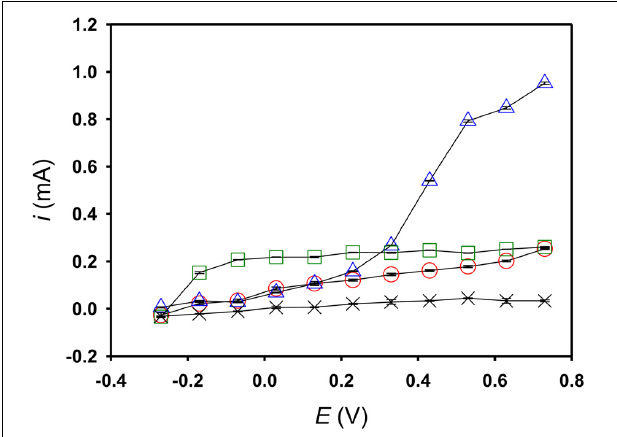
FIGURE 4 | The steady-state catalytic currents of the acetate degradation recorded at different applied potentials. Open circle, S. decoloration NTOU1 digesting acetate without any mediator addition; open square, with 10 µ M riboflavin addition; open triangle, with 10 µ M ferricyanide addition; cross, only the acetate anolyte but without any mediator addition and S. decoloration NTOU1 inculation.